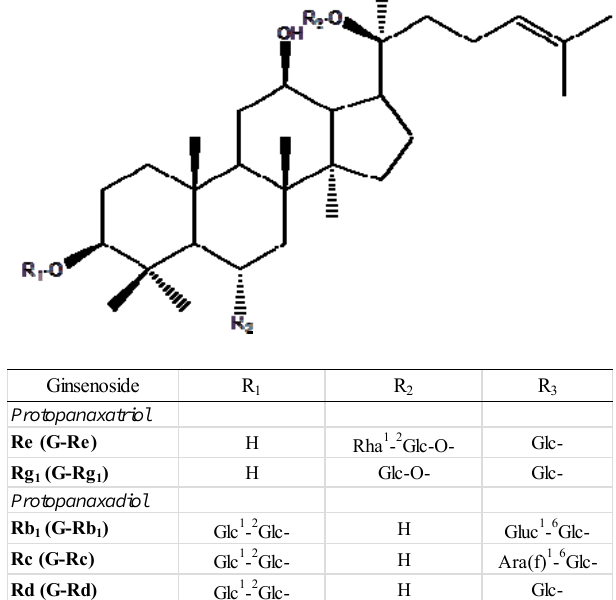
Figure 1. Structures of 5-hydroxy-2-methyl-1,4-naphthoquinone (PL) ( a ) and major ginsenosides ( b